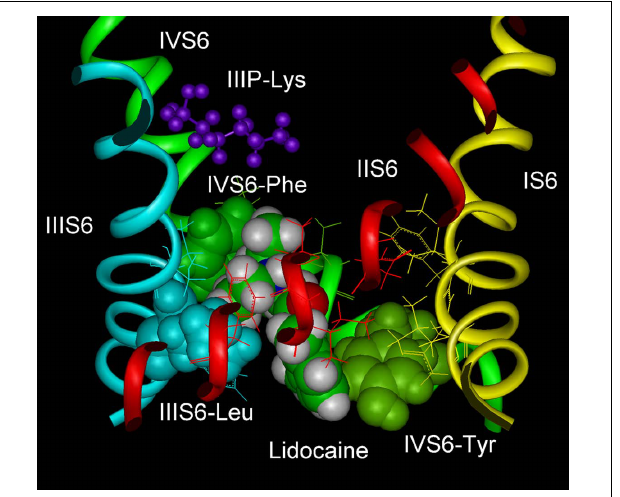
FIGURE 1 | Molecular model of lidocaine in its binding site in the Na channel inner pore. IVS6-Phe and IVS6-Tyr are shown as green space-filled images, and IIIS6-Leu is shown as blue spaced-filled images. IIIP-Lys is part of the DEKA selectivity ring and is shown as purple stick figures. Lidocaine in CPK space-filled images interacts with IVS6-Phe and IVS6-Tyr, almost filling the pore.The figure was prepared by Gregory Lipkind.